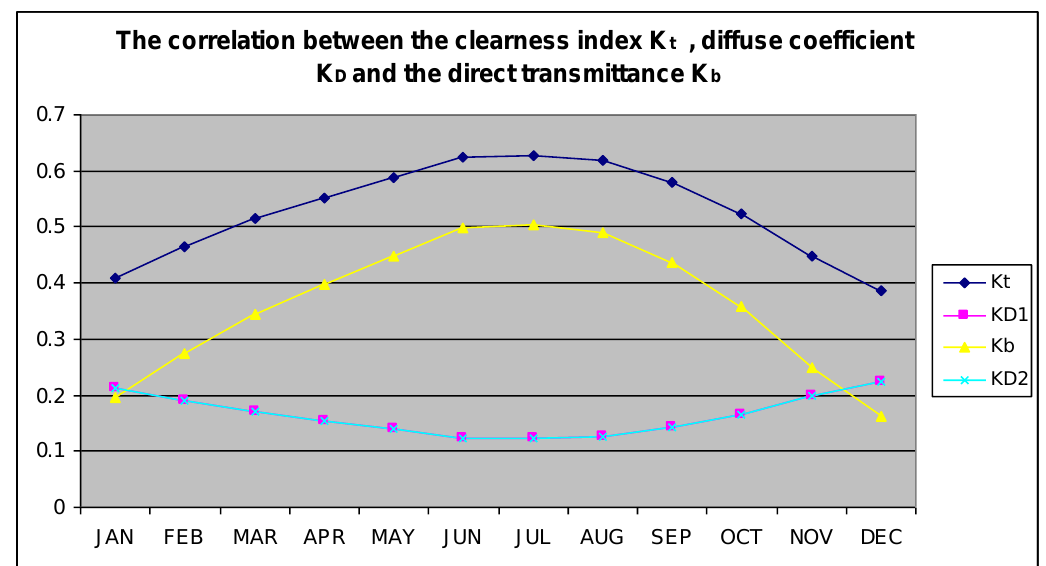
K , K , K , K t b 1 D 2 D